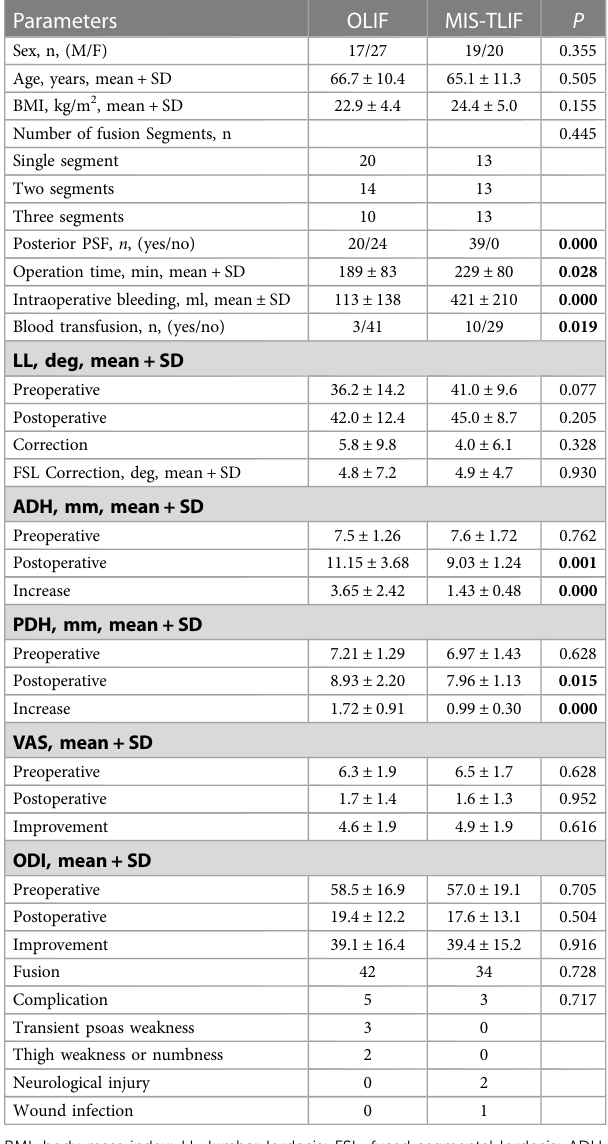
TABLE 1 The comparison of general basic data of OLIF and MIS-TLIF. TABLE 2 The general comparison of OLIF and MIS-TLIF with different number of fused segments.